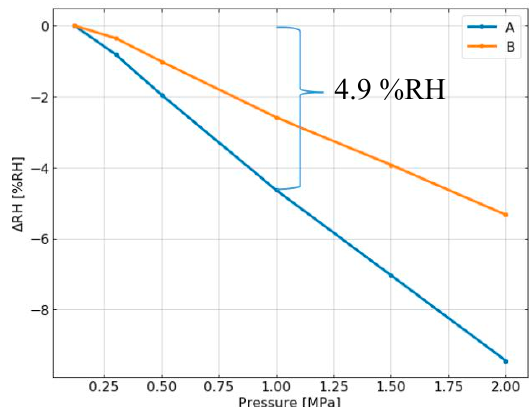
Figure 2. Measurements for an SHT 31 at a set point of 90%RH at 25 °C are plotted as a function of air pressure. Curve A shows the difference between the measured value and the reference—nulled at the first pressure set-point of 0.12 MPa. In curve B the values are corrected by the enhancement factor f w . The remaining difference corresponds to the additional factor f SC .